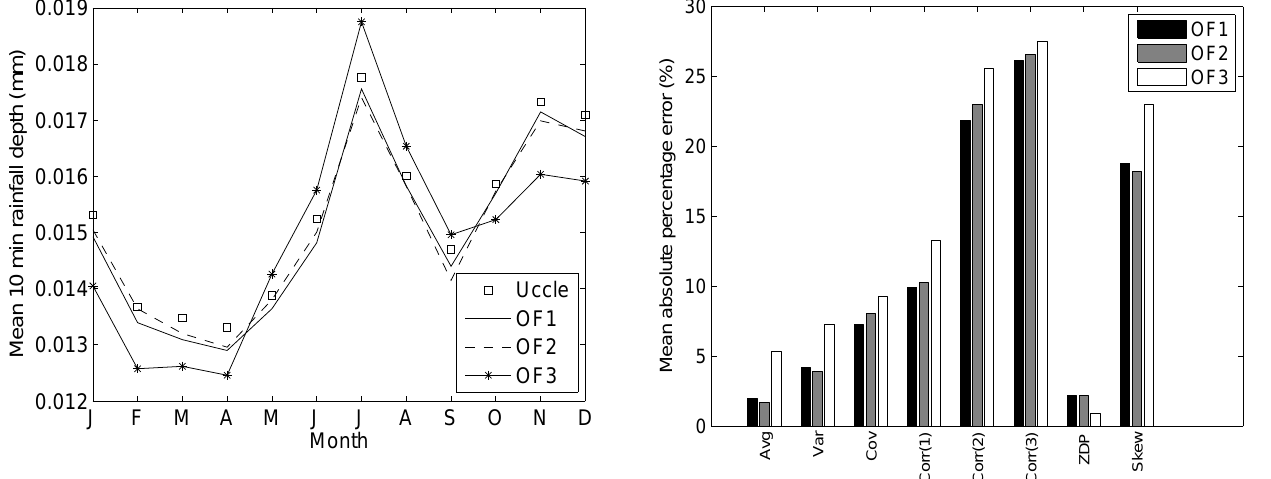
Fig. 11: Mean Absolute Percentage Error of different fits, Fig. 11. Mean Percentage Error of different fits, averaged over dif- ferent months and aggregation levels (10min, 30min, 1h, 6h, 12h averaged over different months and aggregation levels (10 and 24h). Table 8: Final parameters resulting from calibration with Fig. 12: Mean Percentage Error of different fits, averaged OF3 found by each of the optimization methods. over different months and aggregation levels (10 min, 30 min, 1 h, 6 h, 12 h and 24 h)